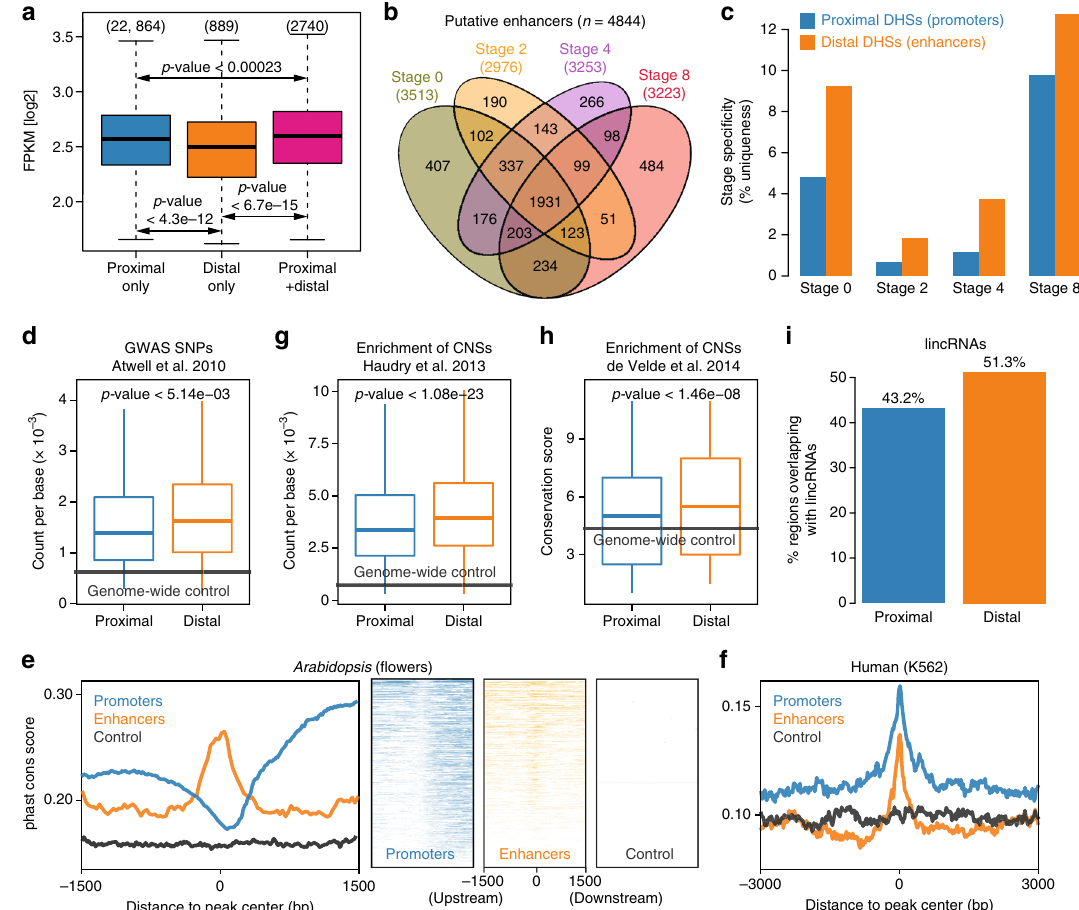
Fig. 3 Identifying and characterizing intergenic DHS-based enhancers. a Boxplots of gene expression for H3K27ac-marked genes associated with only proximal DNase I hypersensitive sites (DHSs), with only distal DHSs, or with both. P -values were calculated based on Wilcoxon signed-rank tests. The number of genes in each category is shown in parentheses. b Venn diagram representing the overlap of putative enhancers identi fi ed in different stages. c Bar chart showing the stage speci fi city, i.e., the called DHSs only existed at one speci fi c stage, of promoters and distal enhancers. d Enrichment of signi fi cant associations for fl owering-related phenotypes from a genome-wide association study (GWAS) 37 . The y axis shows the number of signi fi cant SNPs per basepair. e Distribution of phastCons score around the peak centers of promoter (blue) and enhancer (orange) DHSs in Arabidopsis. The distribution of phastCons score for promoter and enhancer DHSs was plotted in a strand-speci fi c manner, using the orientation of their target genes. As a control, 10,000 random intergenic non-DHS regions were used to calculate the distribution of phastCons score (gray). PhastCons scores between Arabidopsis and other crucifers were taken from ref. 38 for Arabidopsis (nine-way multiple alignment). Left panel, composite (average intensity) plots; right panel, heatmaps of conservation distribution per DHS. f Similar to e (left panel), conversation analysis of human promoter and enhancer DHSs in the K562 cell line. PhastCons scores for humans were taken from the UCSC genome browser (100-way multiple alignment). g Enrichment of conserved noncoding sequences (CNSs) in promoters and enhancers. The y axis shows the number of CNSs per basepair. Data from ref. 38 . h Similar to g , the y axis shows the conservation score. Data from ref. 40 . a , d , g , h Boxplots show the median (horizontal line), second to third quartiles (box), and Tukey-style whiskers (beyond the box). d – h Genome-wide average values were used for control (gray lines). P -values measure statistical signi fi cance based on a Welch ’ s t test. i Percentage of promoters and enhancers overlapping with lincRNA loci. Annotation of lincRNAs were obtained from refs. 41,42 . The underlying source data for a , c , d , and g – i are provided in the Source Data fi